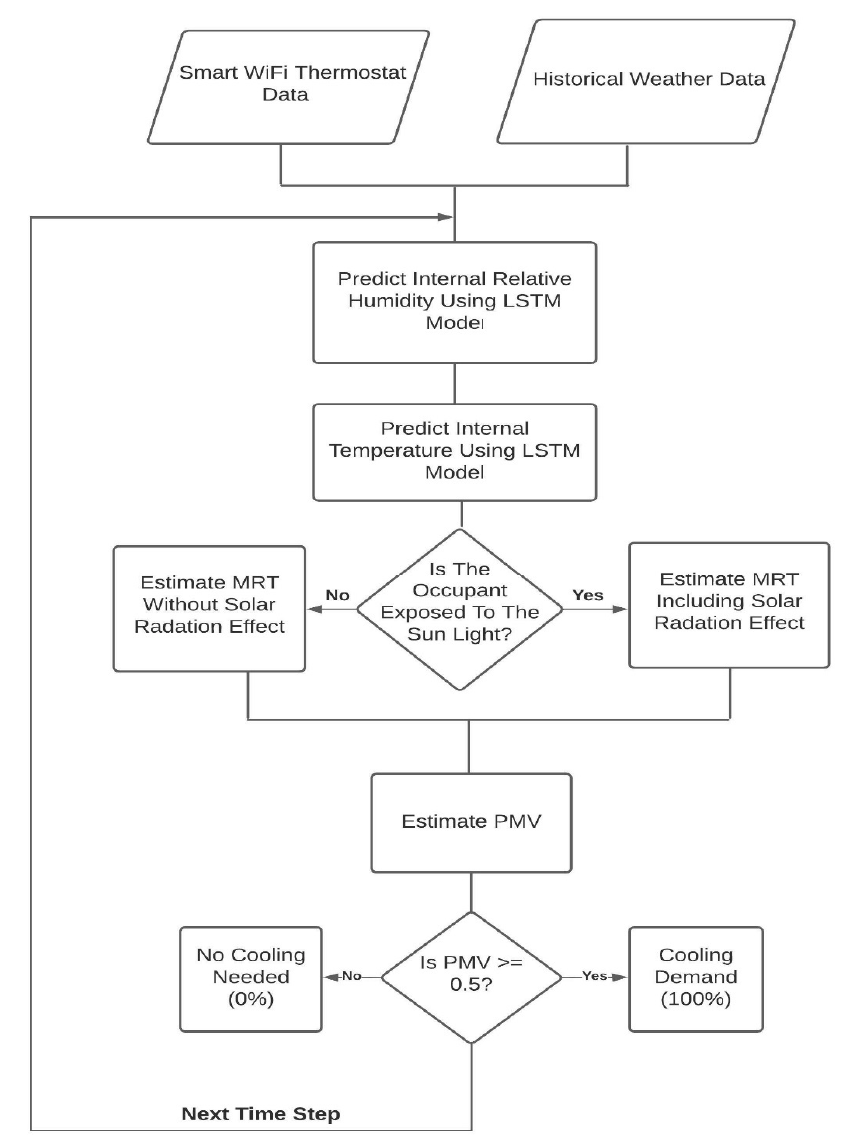
Figure 1. Flowchart showing process for simulated thermal comfort control using two developed LSTM deep learning neural network models of internal relative humidity and